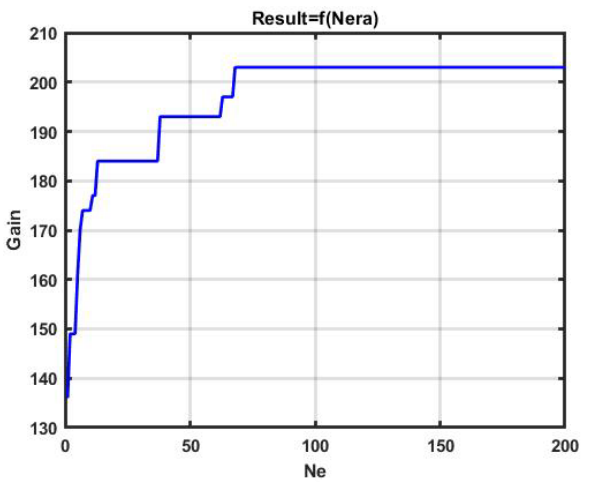
Figure 11. Effectiveness of evolutionary optimized CSF strategy, 50 epochs.